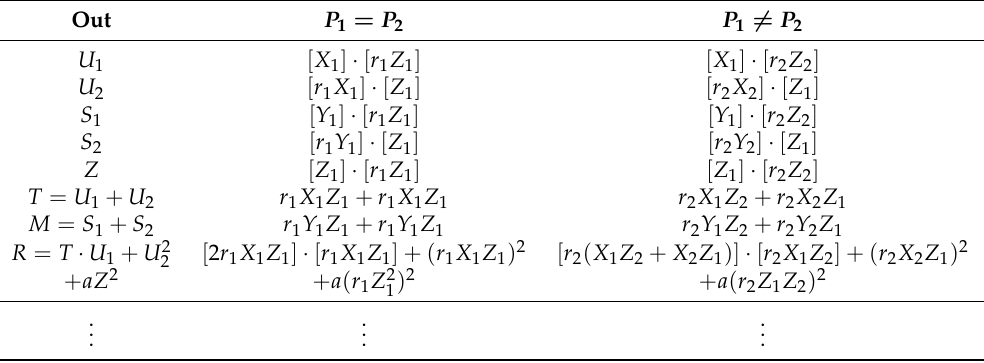
Table A2. The proposed unified point addition method on the Weierstraß elliptic curve by applying w